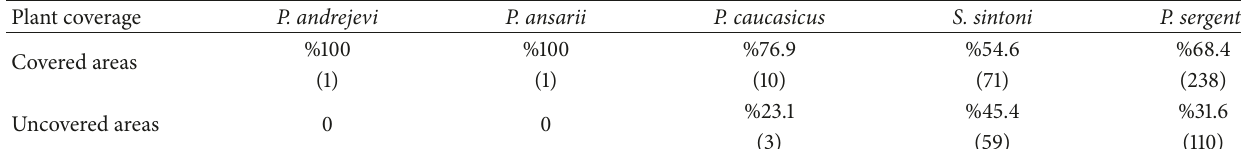
Table 3: The effect of plant coverage on density of sand flies captured in Yazd city, 2015.